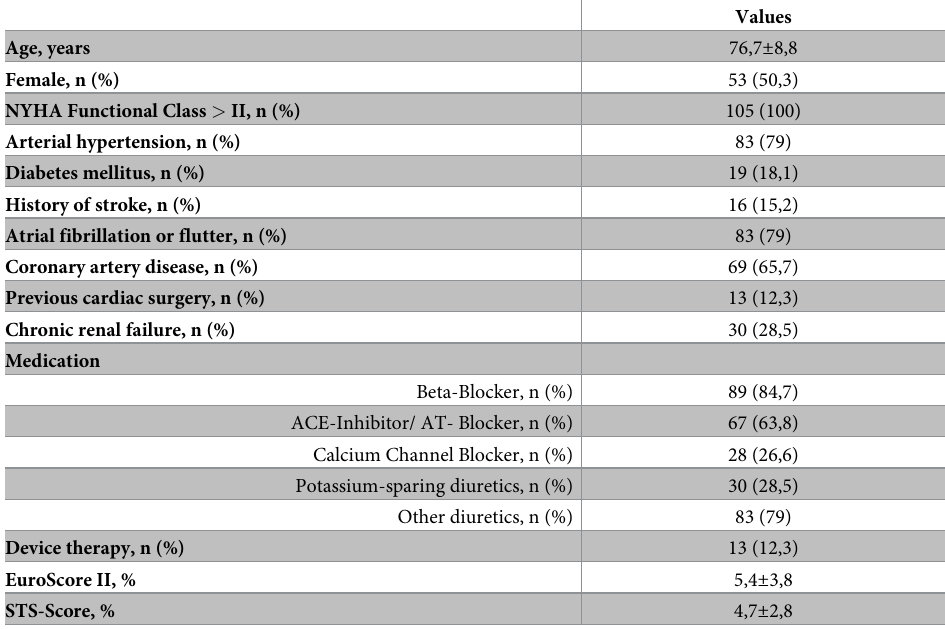
Table 1. Demographical characteristics (N =